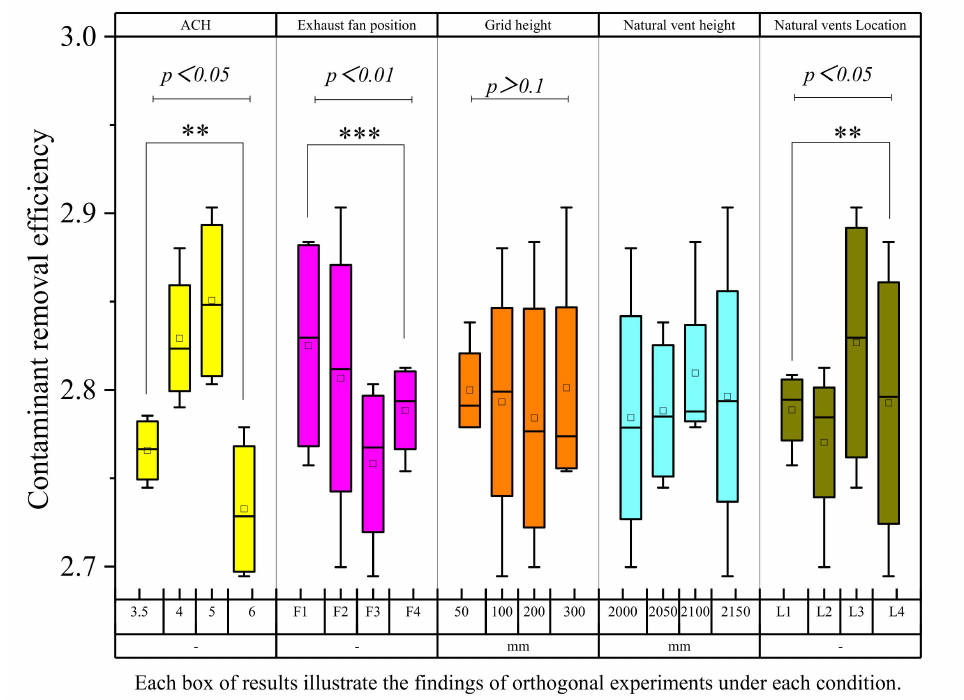
Figure 10. Statistical significance analysis of the orthogonal experiment results for the CRE of